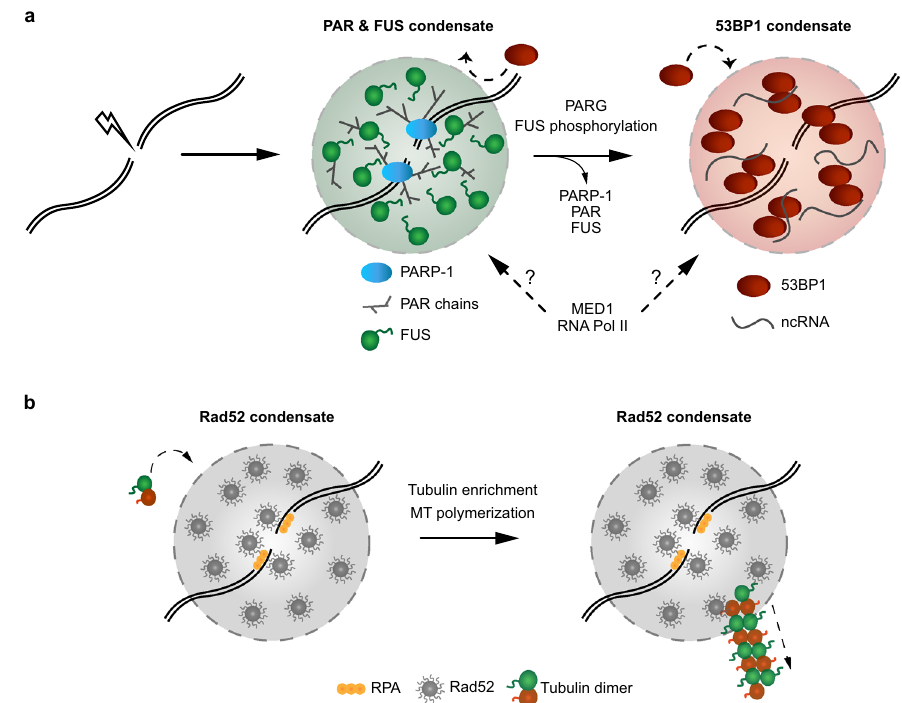
Fig. 3 LLPS in the compartmentalization of damaged DNA. a Mammalian PARP-1 is an early responder at DNA damage sites and synthetizes long negatively charged PAR chains that interact with positively charged RGG motifs present on FUS proteins. LLPS of FUS allows the compartmentalization of the DNA damage site and the exclusion of speci fi c factors, such as 53BP1. Upon PARG activation and FUS phosphorylation, the FUS condensate disassembles and allows for the enrichment and subsequent LLPS of 53BP1. This phenomenon is mediated, at least in part, by the oligomerization domain of 53BP1. The enrichment of the mediator component MED1 and RNA Pol II in either compartment remains to be determined. b Budding yeast Rad52 forms biomolecular condensates at sites of DNA damage. The condensates can concentrate tubulin and drive the polymerization of microtubule fi laments. The fi laments help mobilize damaged DNA inside of the nucleus to promote